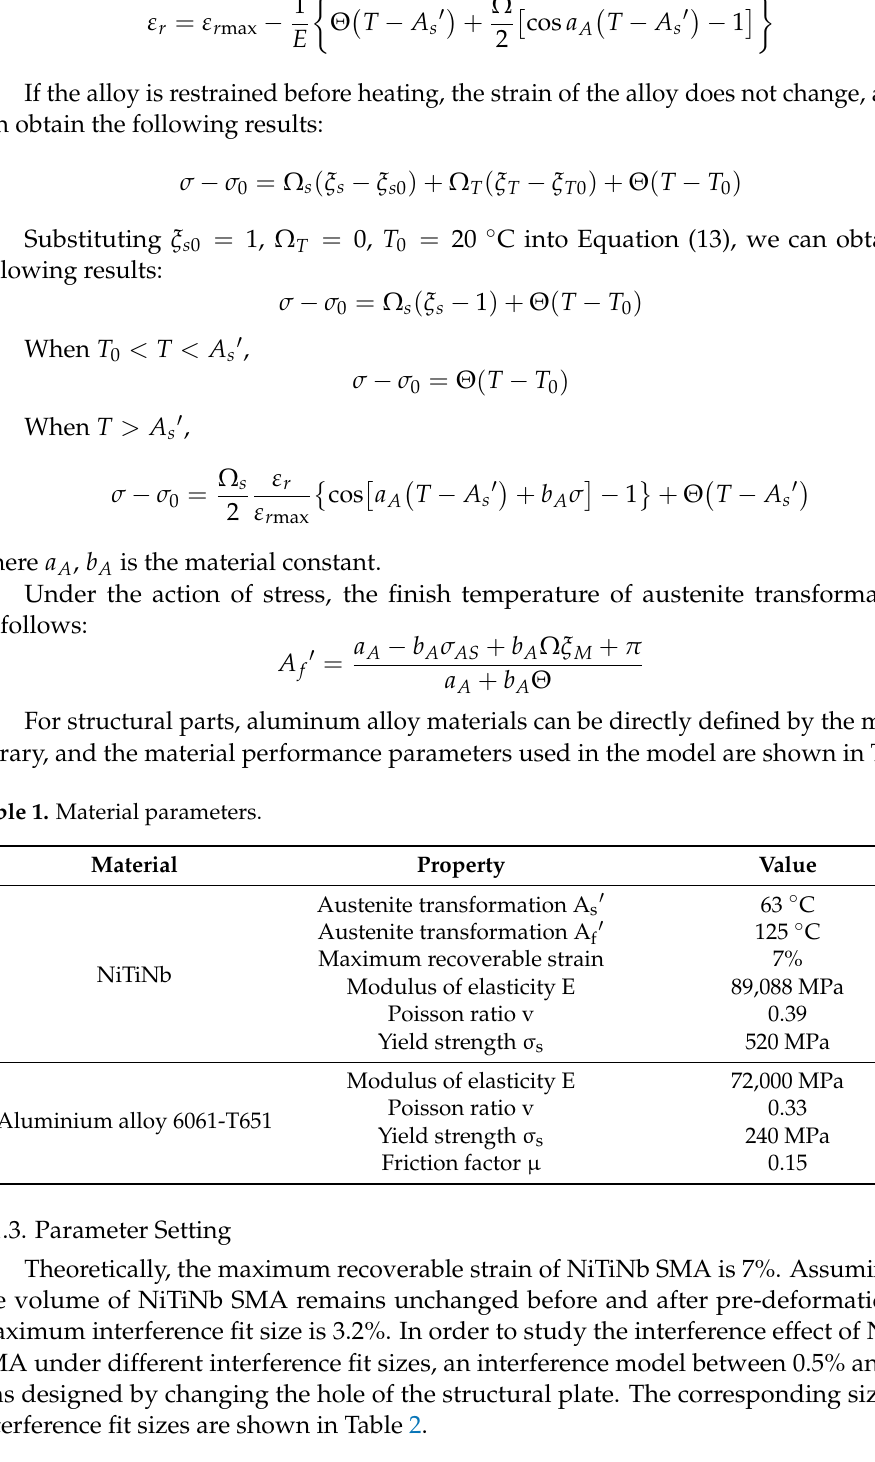
Table 2. Size of hole and shaft with different interference fit